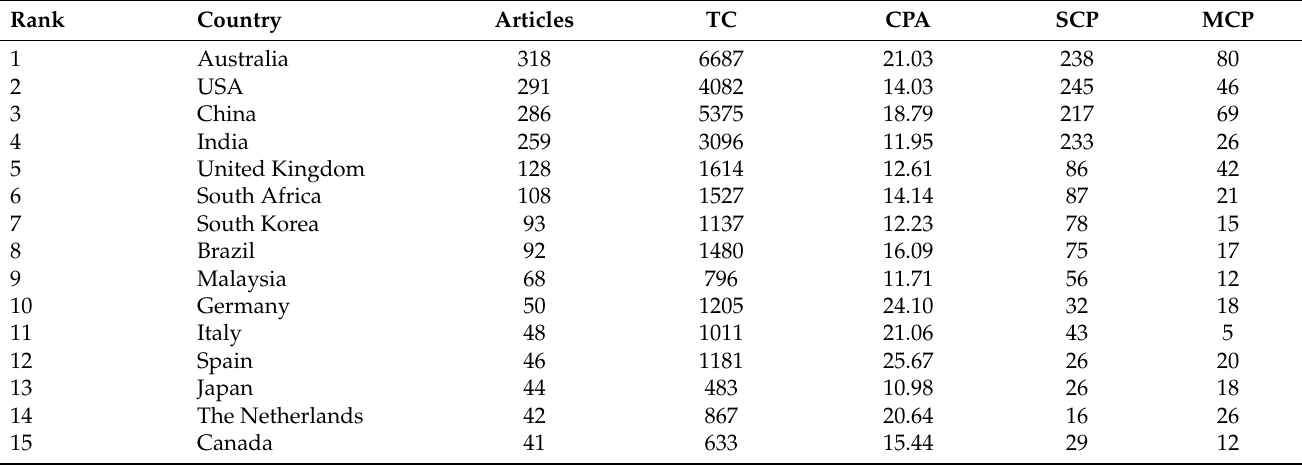
Table 9. The most productive